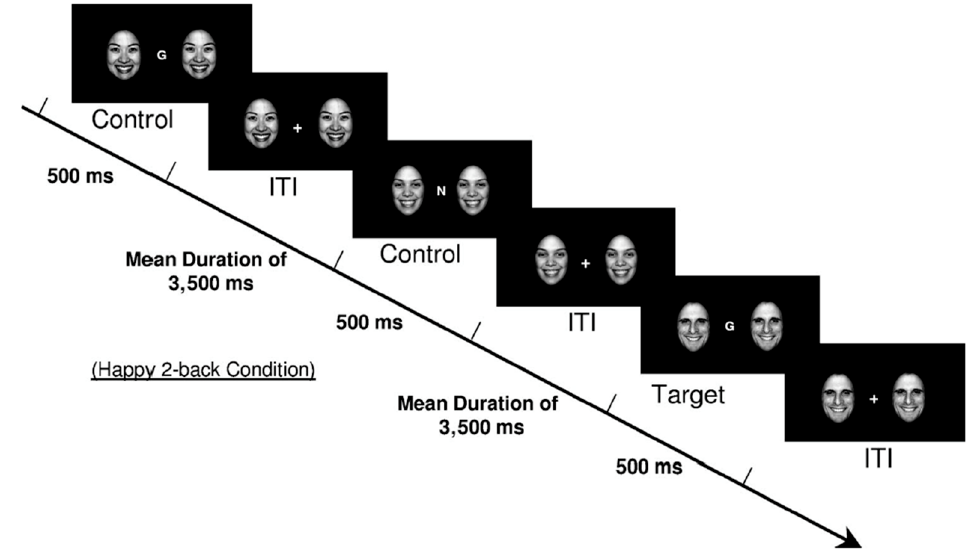
Figure 1. Illustration of the original Emotional Face N-back task (Ladouceur et al. 2009). This is an example of the happy-face 2-back memory-load condition. ITI = intertrial interval. Printed with permission.